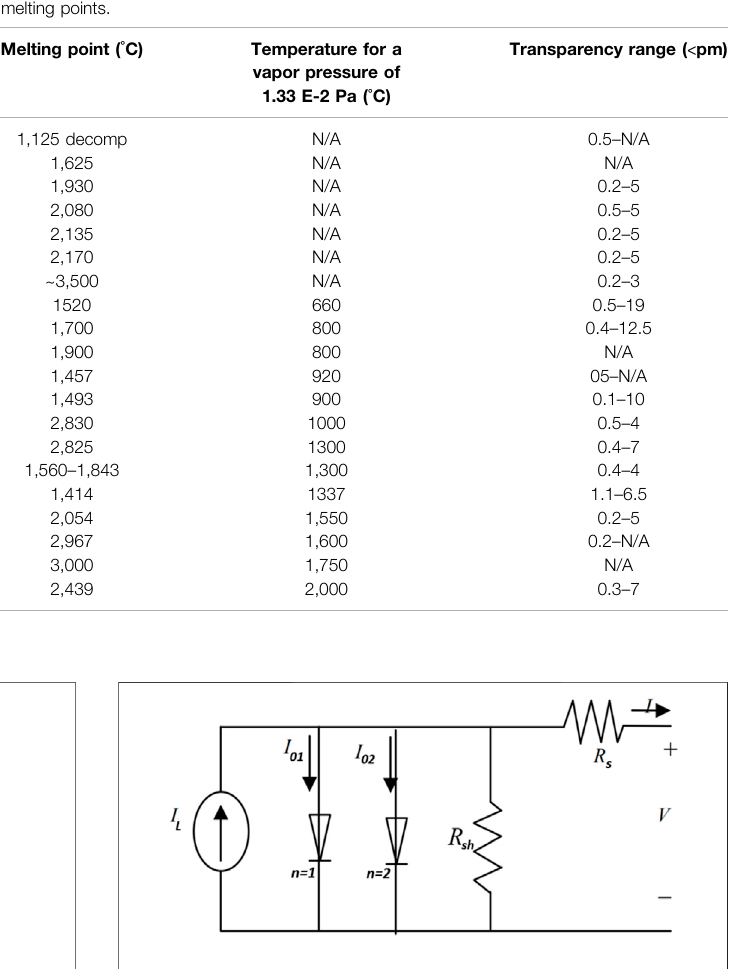
FIGURE 6 | Double diode model equivalent to the TPV system (Jena et al., 2015).